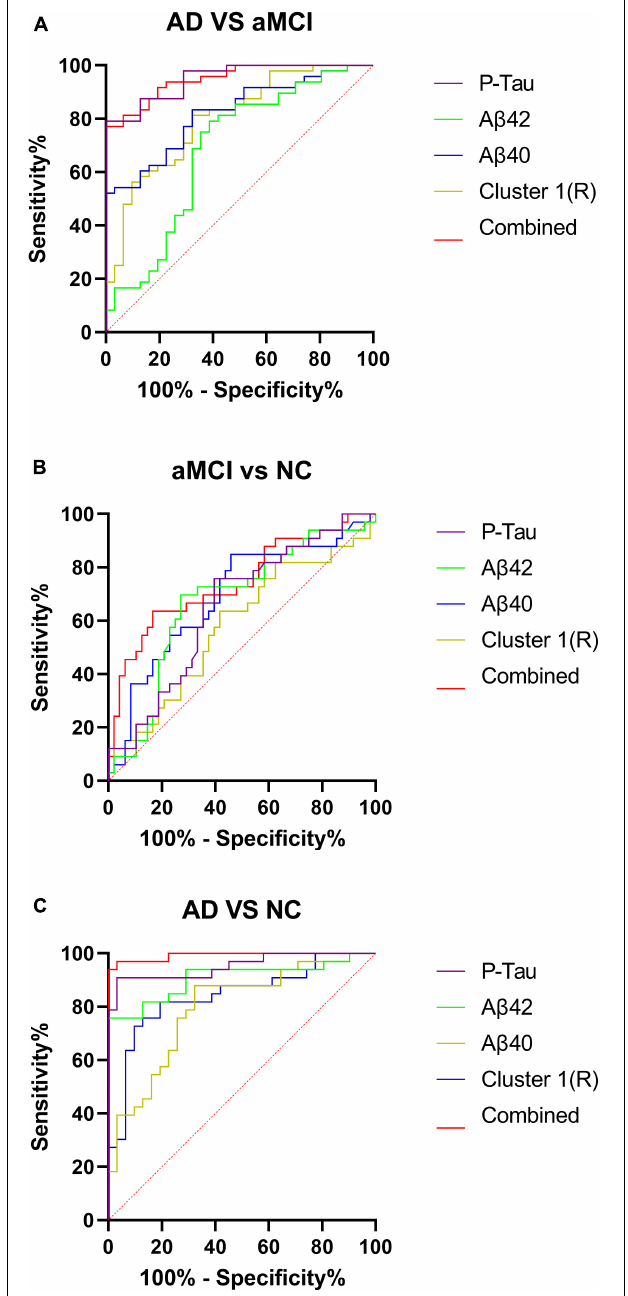
FIGURE 4 | (A–C) Receiver operating characteristic curves for the AD-aMCI, aMCI-NC, and AD-NC groups. AD, Alzheimer’s disease; aMCI, amnestic mild cognitive impairment; NC, normal control.